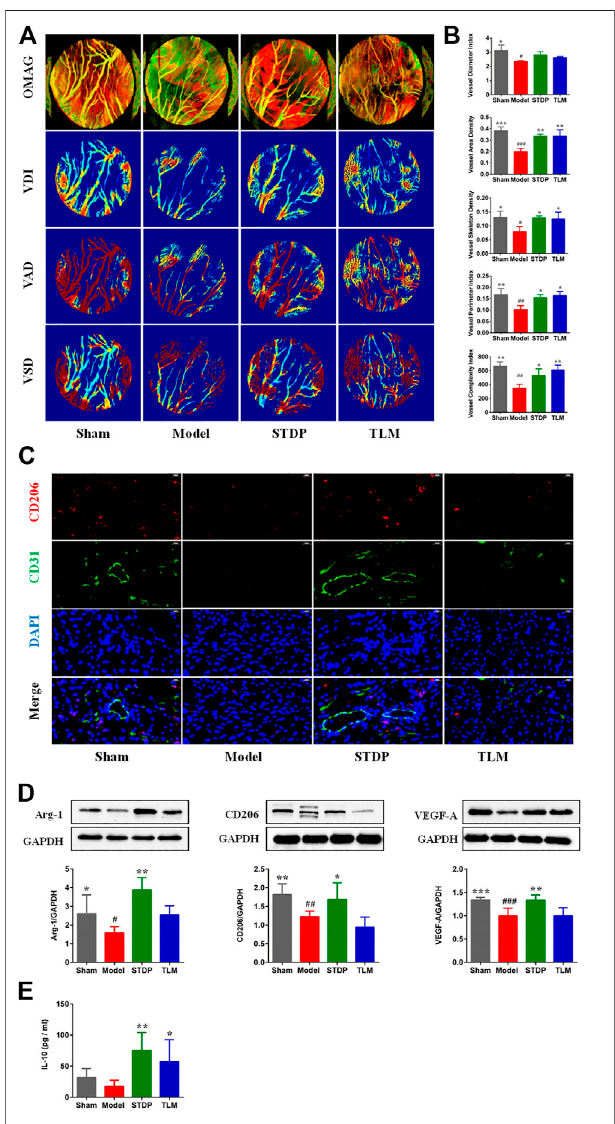
FIGURE 2 | STDPs promoted angiogenesis by inducing polarization of M2macrophagesinischemicmyocardialtissues. (A) Representativereal-time perfusion images of cardiac vessels by optical microangiography (OMAG). (B) Vessel diameter index (VDI), vessel area density (VAD), vessel skeleton density (VSD), vessel perimeter index, and vessel complexity index analysis in different groups. N = 3 per group. (C) IF staining of CD206 and CD31 in different groups. N = 3 per group. (D) Immunoblots and the quanti fi cation of Arg-1, CD206, and VEGF-A, N = 6 per group. (E) The level of IL-10 in serum. N = 6 per group. * p < 0.05, ** p < 0.01 vs . the model group; # p < 0.05, # # p < 0.01 vs. the sham